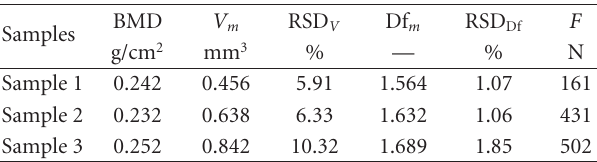
Figure 6: Relation between force F and mean volume V m . Table 3: Microarchitecture characteristics of selected samples with similar bone mass